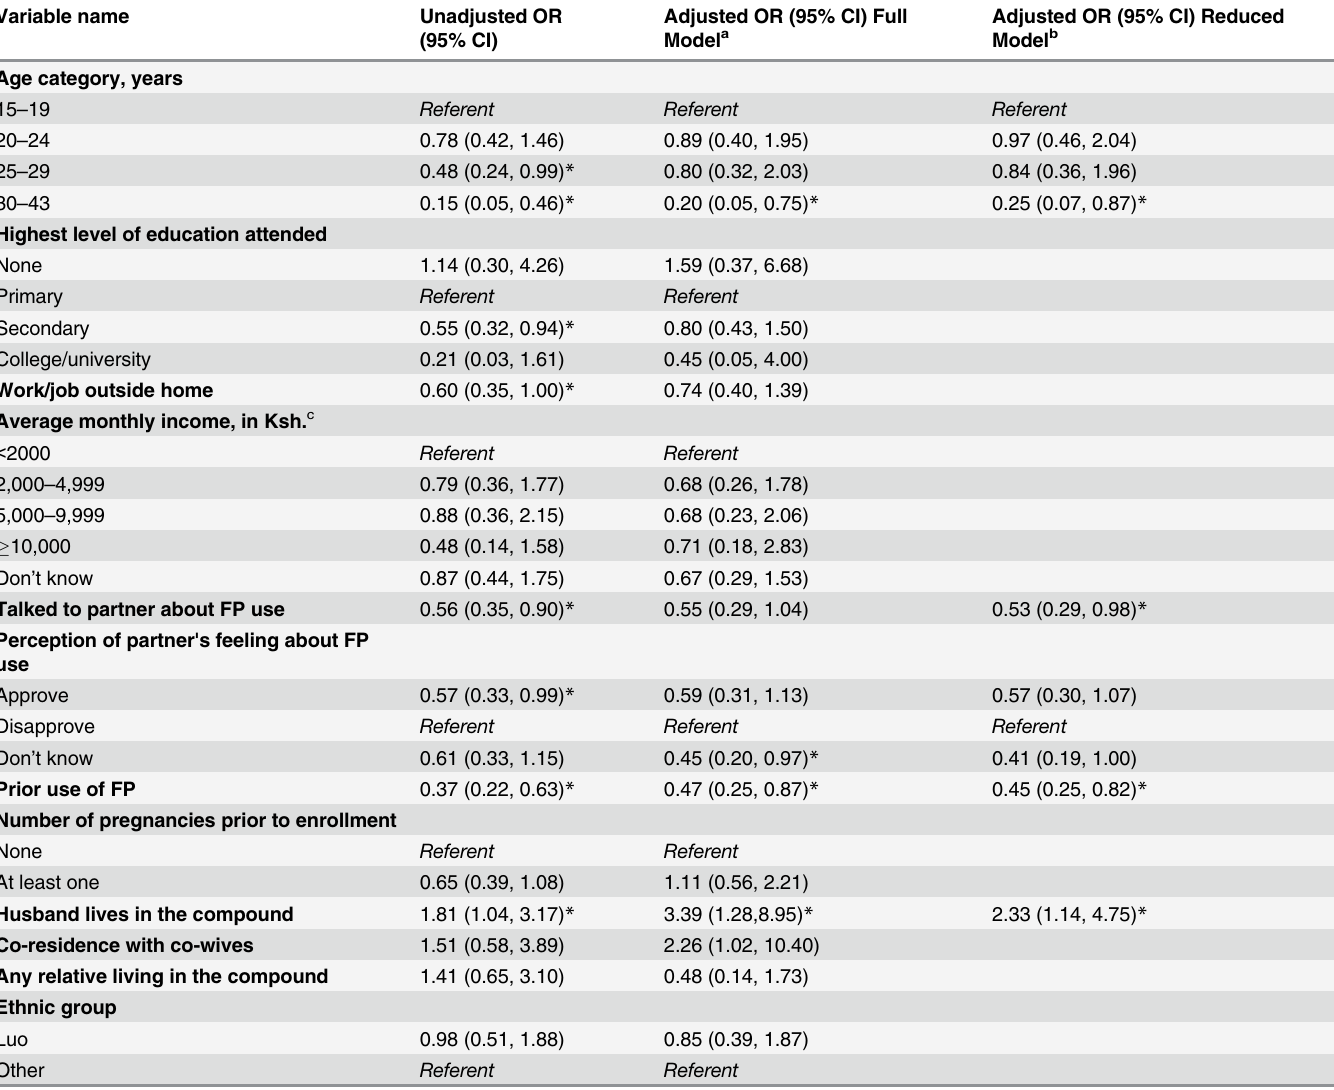
Table 3. Determinants and experiences of repeat pregnancy: multivariate analysis among HIV-infected women in the Kisumu breastfeeding study, Kenya, 2003 –